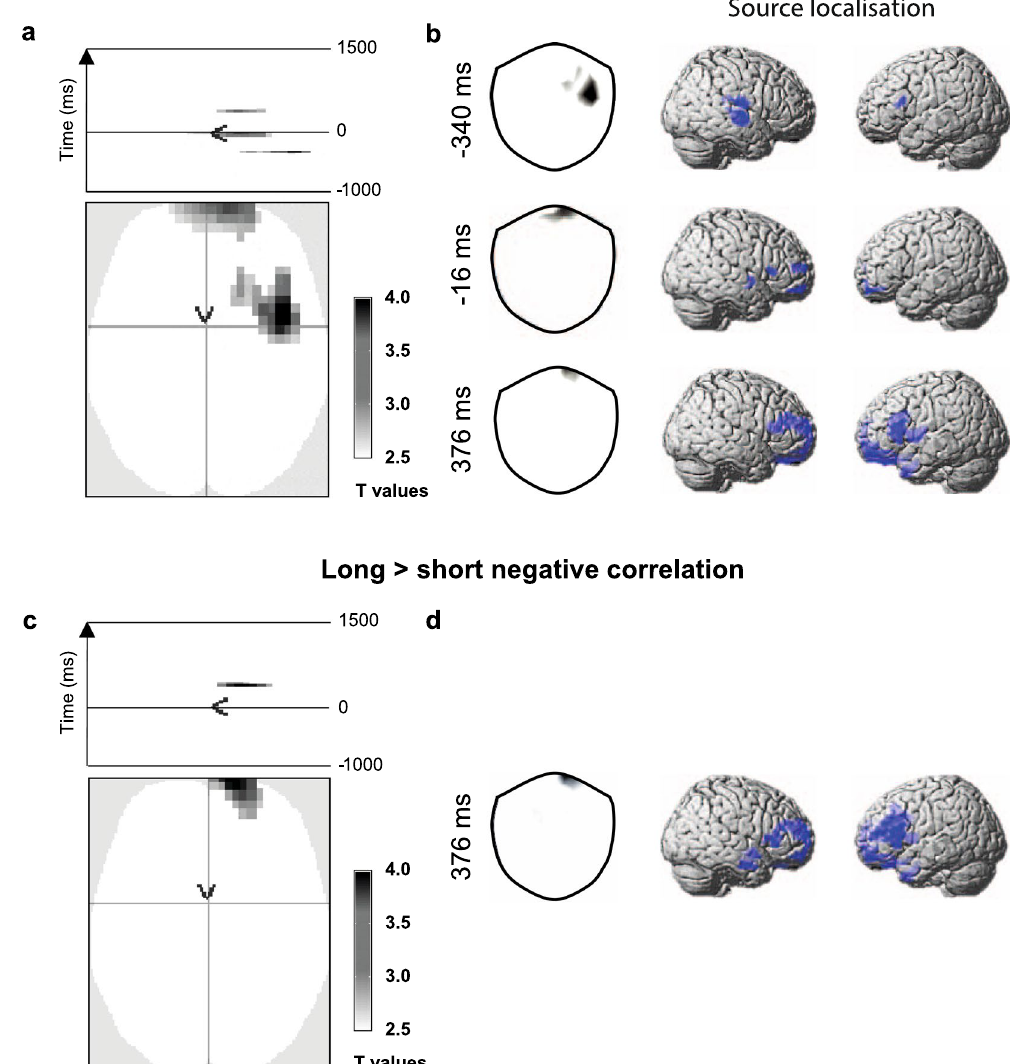
Figure 4. Selection entropy correlations with MEG. ( a ) The significant negative correlations between SE and planar gradiometer data, averaged across all SE windows in sensor-time space (voxel threshold: p < 0.001, t > 3.17 with 50 voxel cluster thresholding 11 ). Negative correlations were observed both before and after the response at t = 0 ms. ( b ) The t-maps (left) show the scalp location of the significant correlations at the peak time point of each cluster. We visualised the location of the neural sources (right) within a 20 ms time window around each of these time-points (p < 0.01, t > 2.36). At t = − 340 ms, source peaks were observed in the right central operculum and left inferior frontal gyrus. At t = − 16 ms, source peaks were observed in right anterior middle frontal gyrus, left bilateral anterior orbital gyrus and right superior temporal gyrus. At t = 376 ms source peaks were observed in the left anterior orbital gyrus, right frontopolar prefrontal cortex, left inferior frontal gyrus and left temporal pole. ( c ) Clusters in sensor-time space with significantly greater negative correlations in the frontal pole for longer trial windows (thresholding as panel a). ( d ) The t-maps (right) show location of the significant differences between window lengths at the peak time point of the significant cluster. This was localised (right) to the left inferior frontal gyrus, left anterior orbital gyrus and right superior frontal gyrus (thresholding as panel